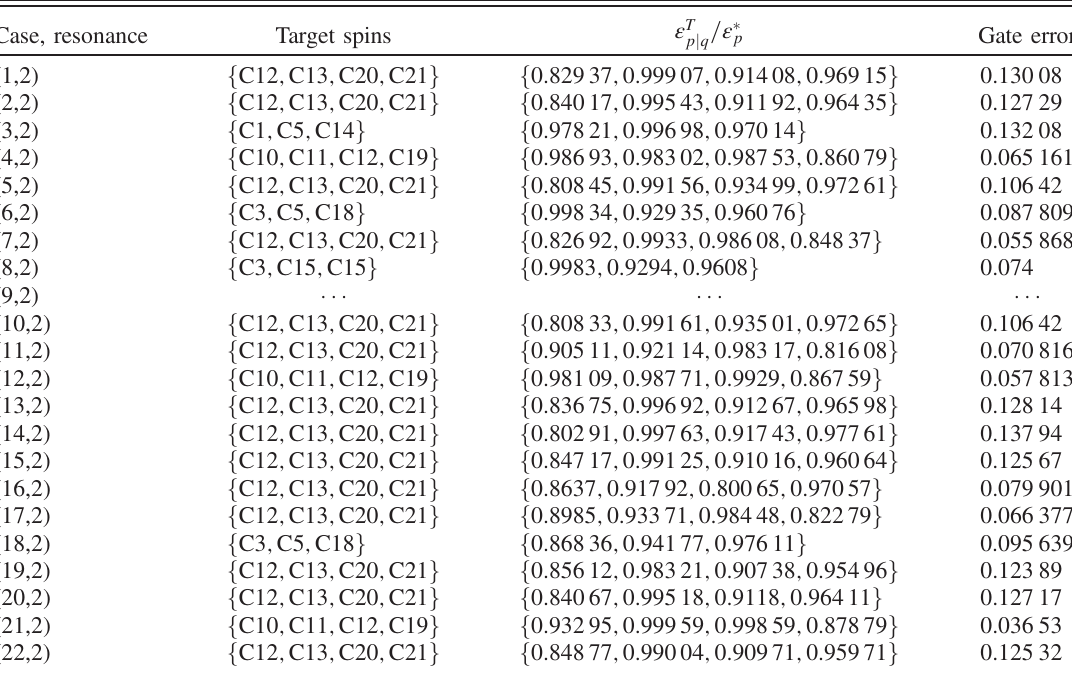
TABLE VII. Target spins, one-tangles, and gate error for each case number for the k ¼ 2 resonance in Fig. 8. Case,